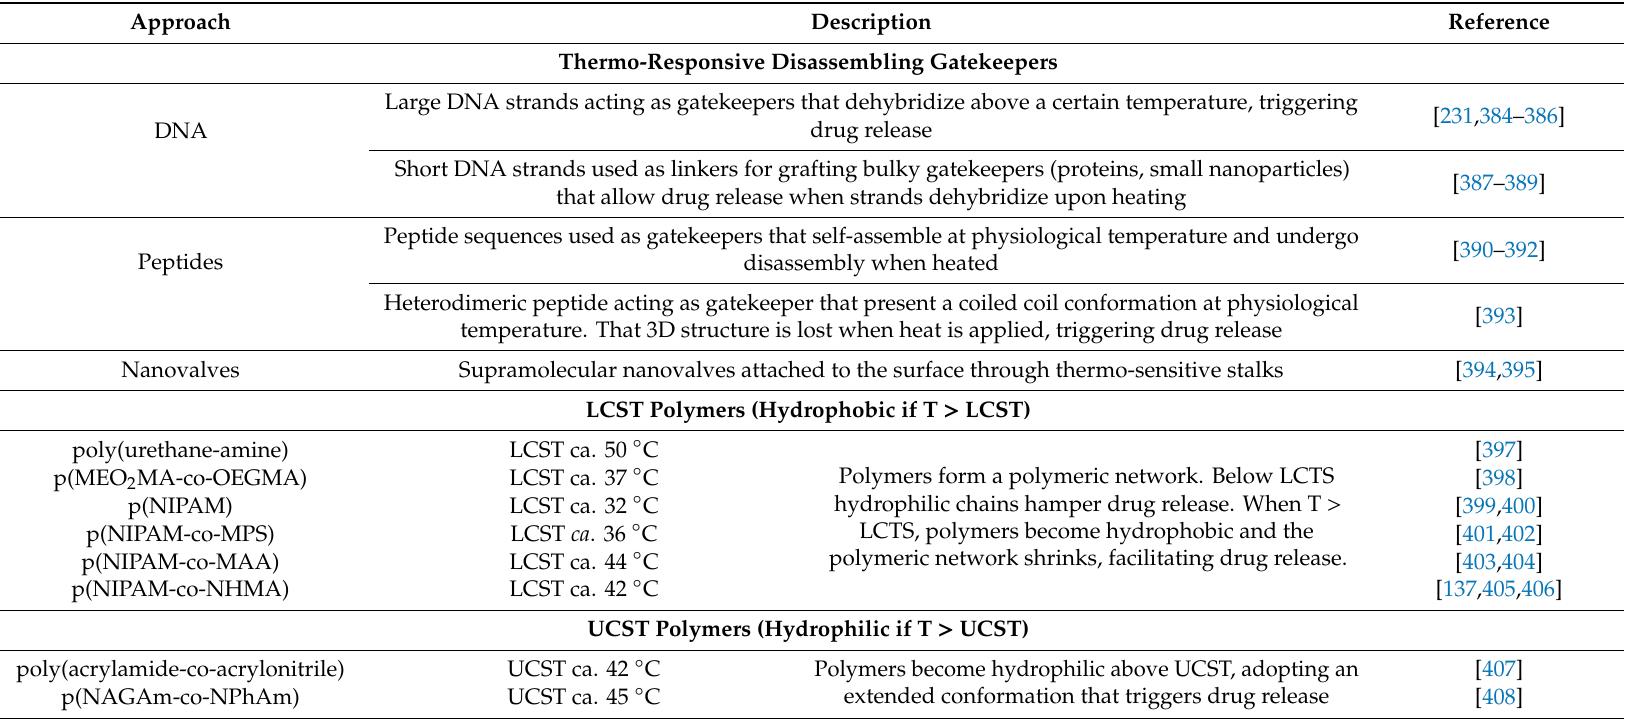
Table 6. Di ff erent strategies implemented into MSNs for achieving light-responsive drug